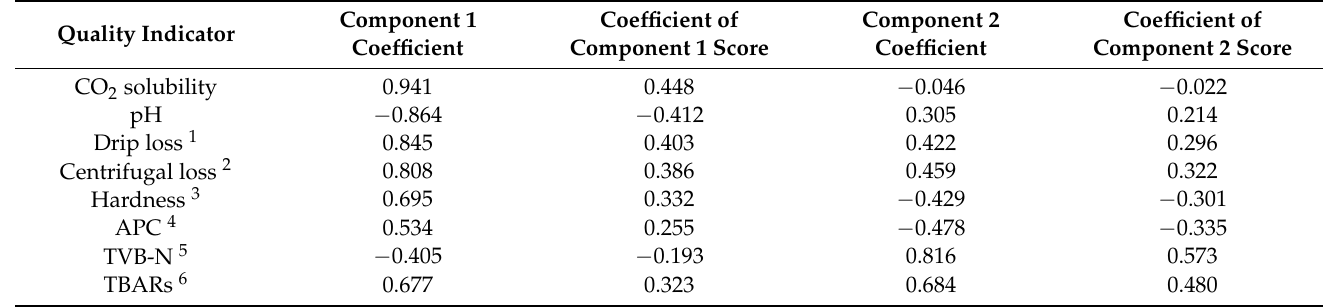
Table 3. Loading matrix for principal component analysis of quality indicator in golden pompano fillets during